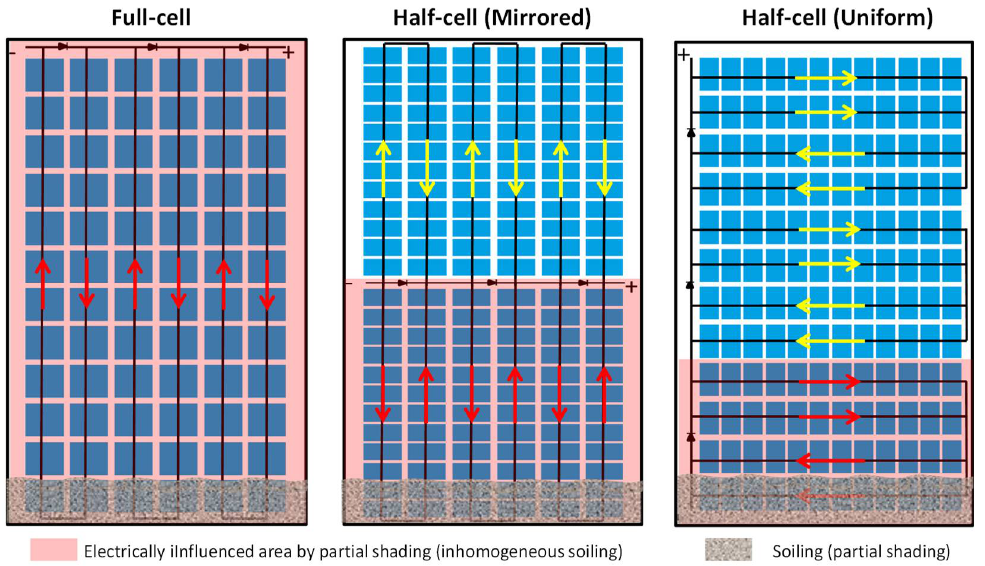
Figure 14. Influenced area under inhomogeneous partial shading induced by dust accumulation for ( left ) full cell, ( middle ) half cell with a mirrored design and ( right ) half cell with uniform design (adapted with permission from [66]).